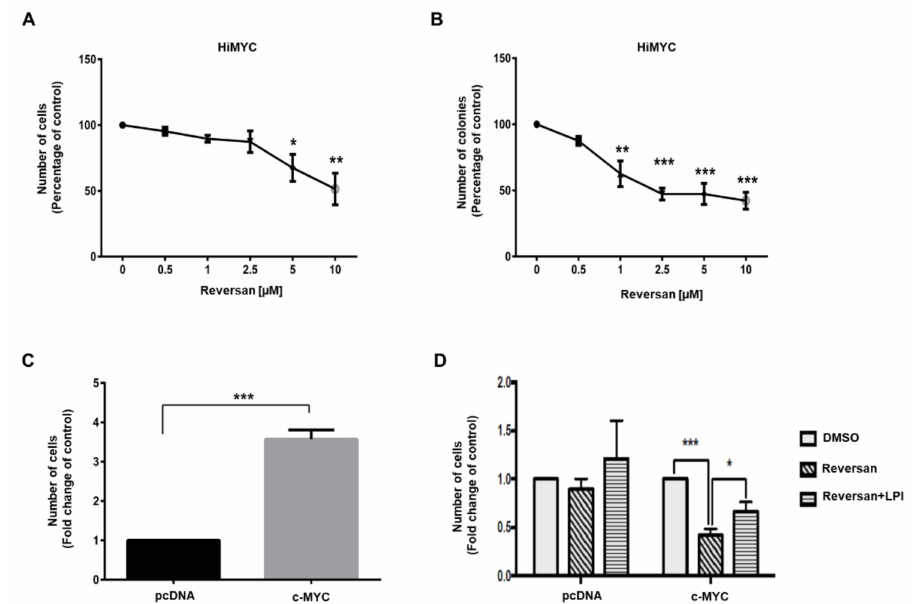
Figure 5. C-MYC regulates prostate cell growth in a mechanism involving ABCC1 / LPI. ( A ) HiMYC cells were treated with the indicated concentrations of Reversan. Number of cells was assessed after 72 h by cell counting. Data are expressed as percentage of cells treated with vehicle, DMSO, and are means ± SEM from n ≥ 3 independent experiments. * p < 0.05, ** p < 0.01. ( B ) HiMYC cells were plated on soft agar and treated with increasing concentrations of Reversan. Number of colonies was assessed after 4 weeks. Data are expressed as percentage of cells treated with DMSO and are means ± SEM from n ≥ 3 independent experiments. ** p < 0.01, *** p < 0.001. ( C ) Immortalised epithelial prostate cells PNT2 were transfected with a plasmid encoding c-MYC or the corresponding empty vector (pcDNA). Number of cells was assessed after 72 h by cell counting. Data are expressed as fold change of pcDNA-transfected cells and are means + SEM from n = 3 independent experiments. *** p < 0.001. ( D ) PNT2 cells transfected with pcDNA or c-MYC-expressing plasmid were incubated with DMSO (control), Reversan (10 µ M) or Reversan (10 µ M) and LPI (10 µ M) for 72 h. Data are expressed as fold change of each corresponding DMSO-treated cells and are means + SD of n = 4 independent experiments. * p < 0.05, *** p <